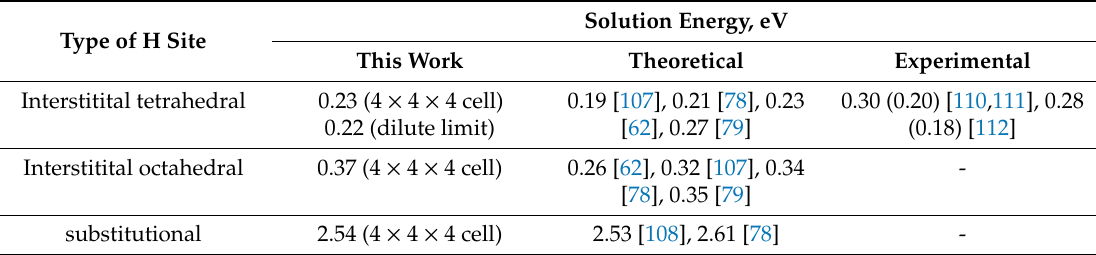
Solution energies of H in pure Fe. The results are compared to the available theoretical [62,78,79,107,108] and experimental [110–112] data. The experimental data extrapolated to 0 K with ZPE [62] excluded are shown in